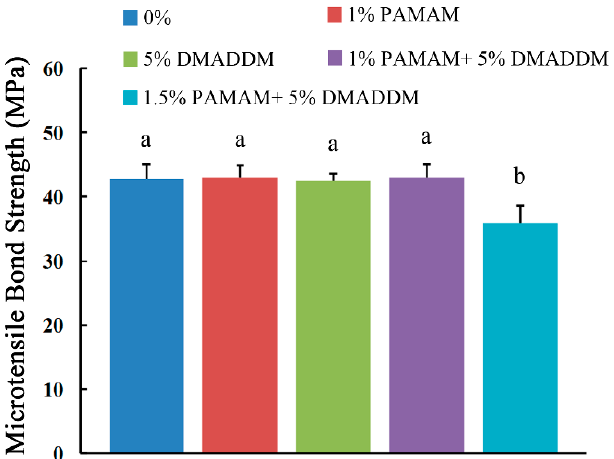
Figure 1. Microtensile bond strength of adhesive (mean ± sd; n = 6). Bars with the same letter indicate values that have no significant difference ( p > 0.1) and those with the dissimilar letters indicate a significant difference ( p < 0.05).